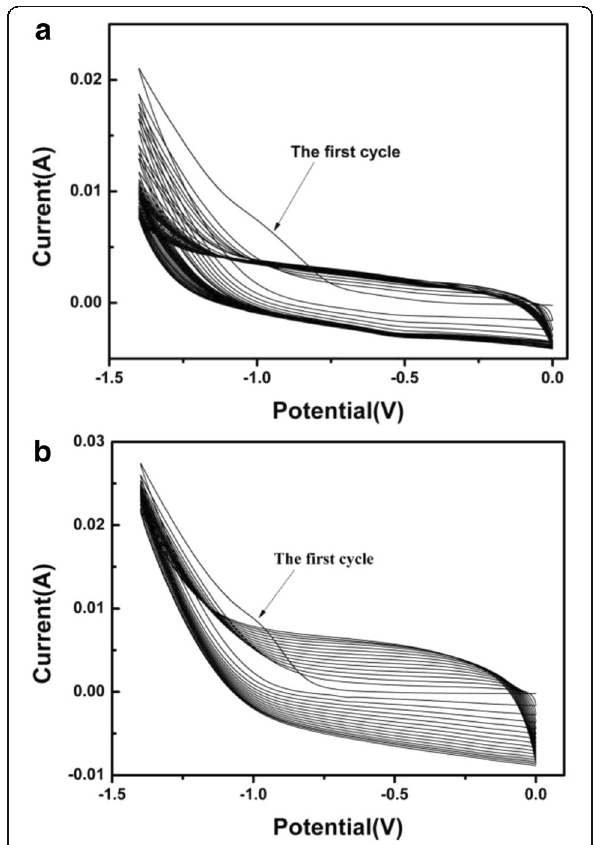
Fig. 4 Electrochemical reduction of a GO and b GO/CNTs (mass ratio 50:1) in 0.5 M Na 2 SO 4 (pH 6.0) at a scan rate of 50